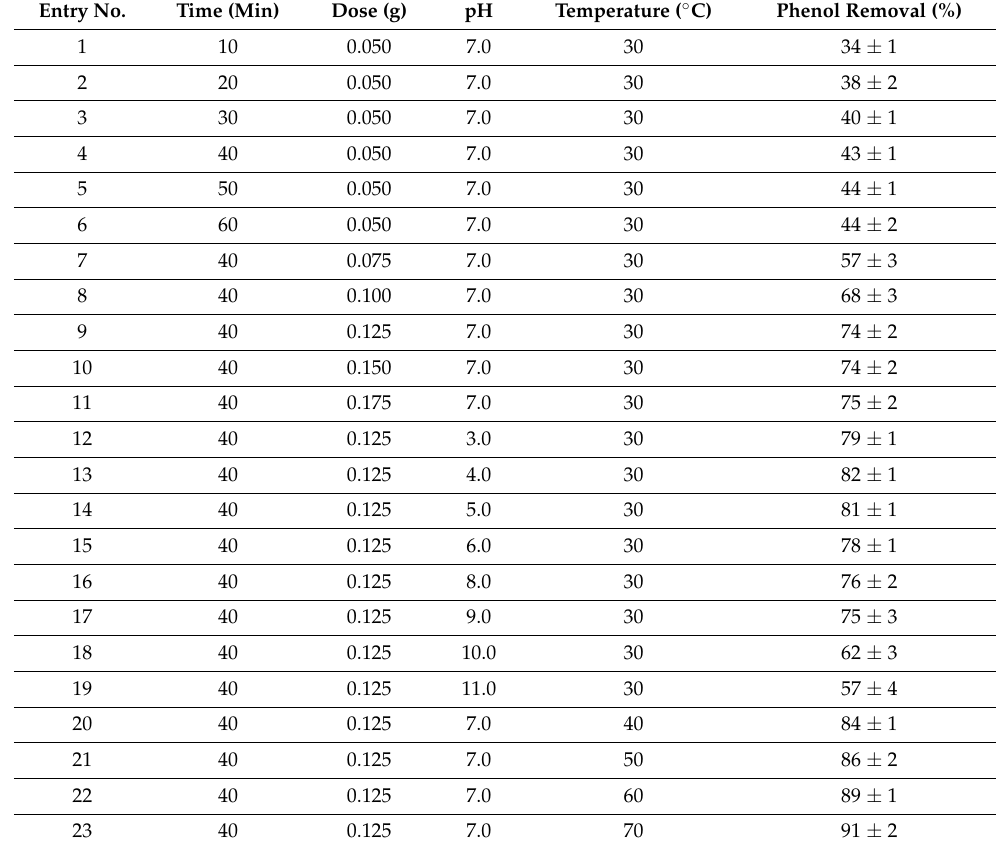
Table 3. Details of reaction conditions and the % removal of phenol under each particular condition.